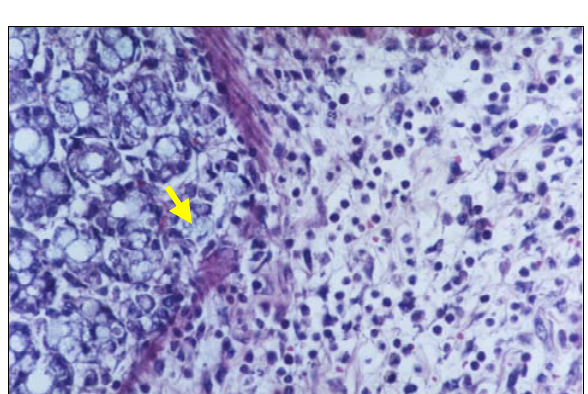
FIGURA 6 – Fotomicrografia de edema e infiltrado leucocitário moderado, animal Passiflora três dias. He